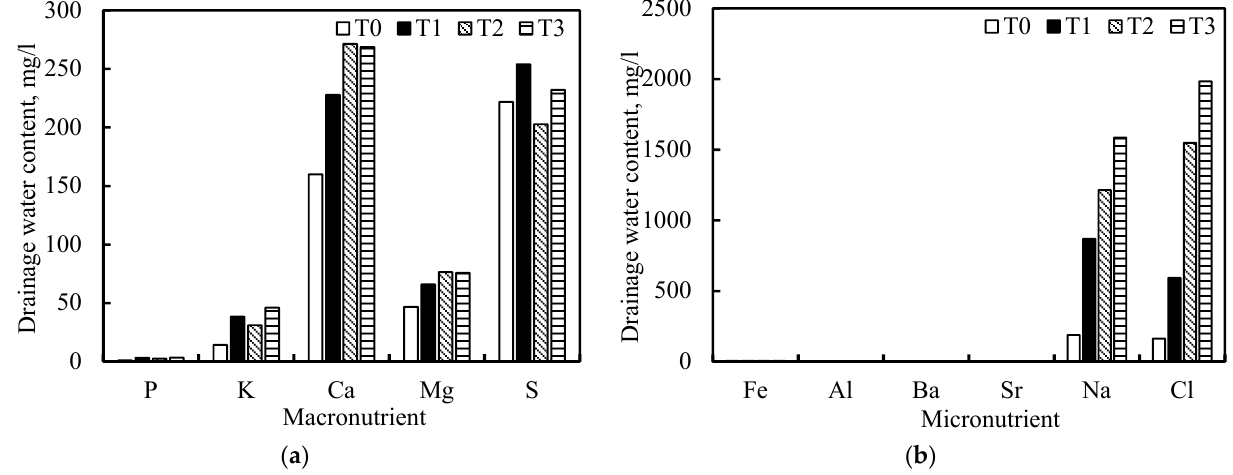
Figure 4. Macronutriment ( a ) and micronutrient ( b ) levels in the drainage water.